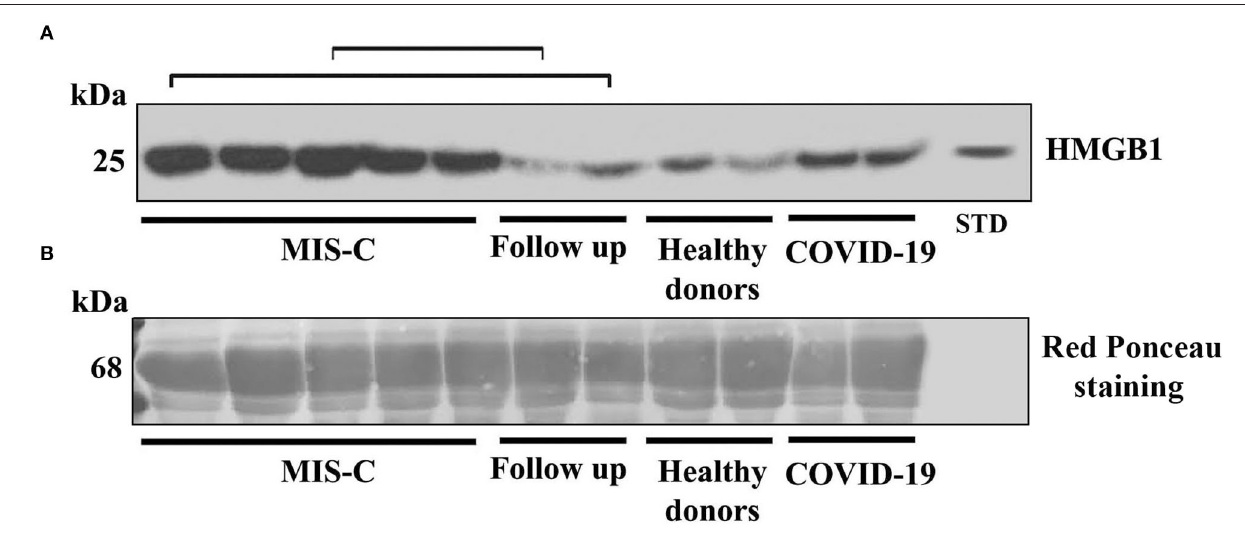
FIGURE 1 | (A) Western blot analysis of high-mobility group box 1 (HMGB1) expression in the serum of patients with the multisystem inflammatory syndrome in children (MIS-C), children with a recent history of COVID-19, healthy donors, and in two of the five children that performed a follow-up as indicated by square brackets. A representative blot for each group is shown. Patients with MIS-C ( n = 5), children with recent history of COVID-19 ( n = 2), healthy donors ( n = 2), and follow up ( n = 2). HMGB1 levels were detected by Western blot using rabbit anti-HMGB1 polyclonal Ab, and proteins were detected using ECL reagents. HMGB1 standard was included in the blot as an internal control. (B) Blot membrane was stained for total protein with Red ponceau, as a control for loading and transfer. The kDa indicates the approximate region of the blot where albumin would be